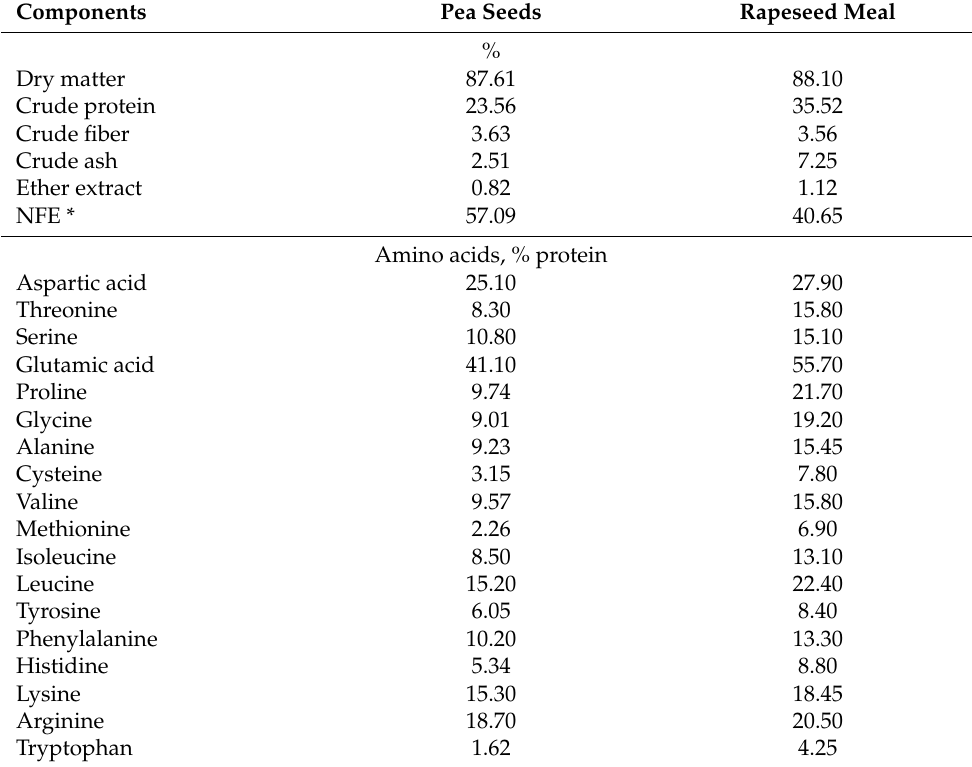
Table 2. Chemical composition of pea seeds (Hubal variety) and rapeseed